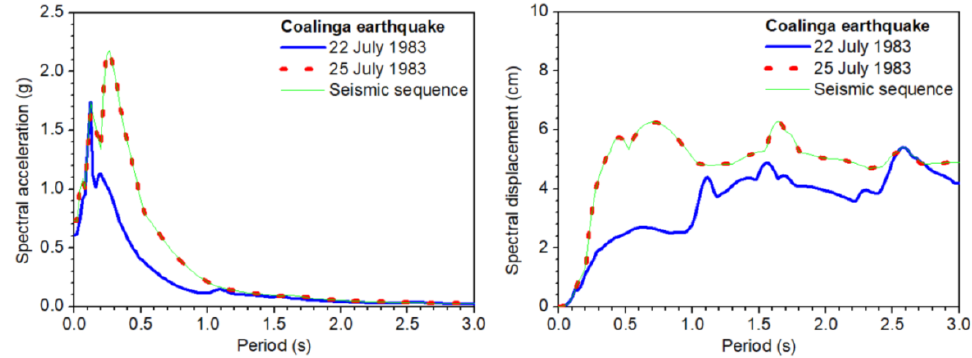
Figure 4. Elastic response spectra for the Coalinga earthquakes: single seismic events and seismic sequence.